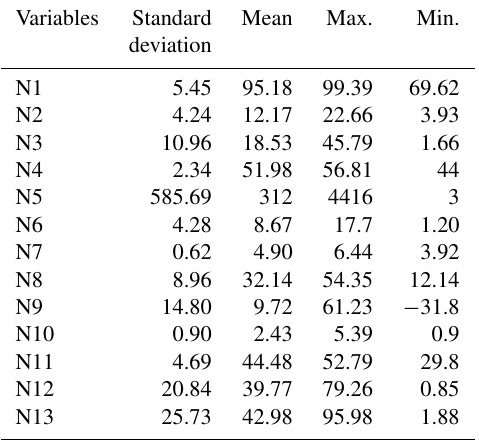
Table 3. Descriptive statistics of variables considered for social vul- nerability assessment.